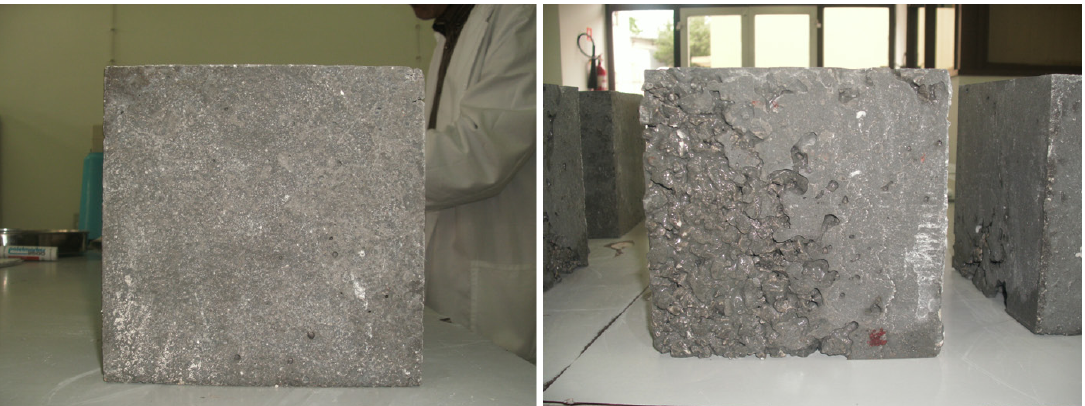
Figure 9. The appearance of the surface of ESCC samples - two samples (good - left, bad - right).